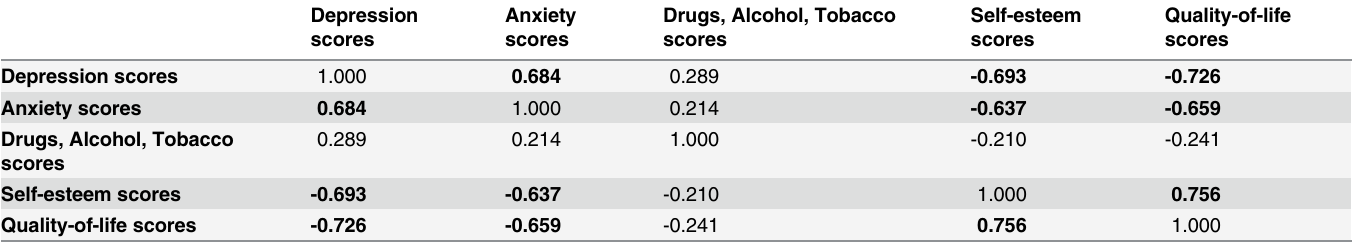
Table 4. Correlations between the scores on the 5 subscales in the combined EMPATHY scale score, using Spearman ’ s rank correlation